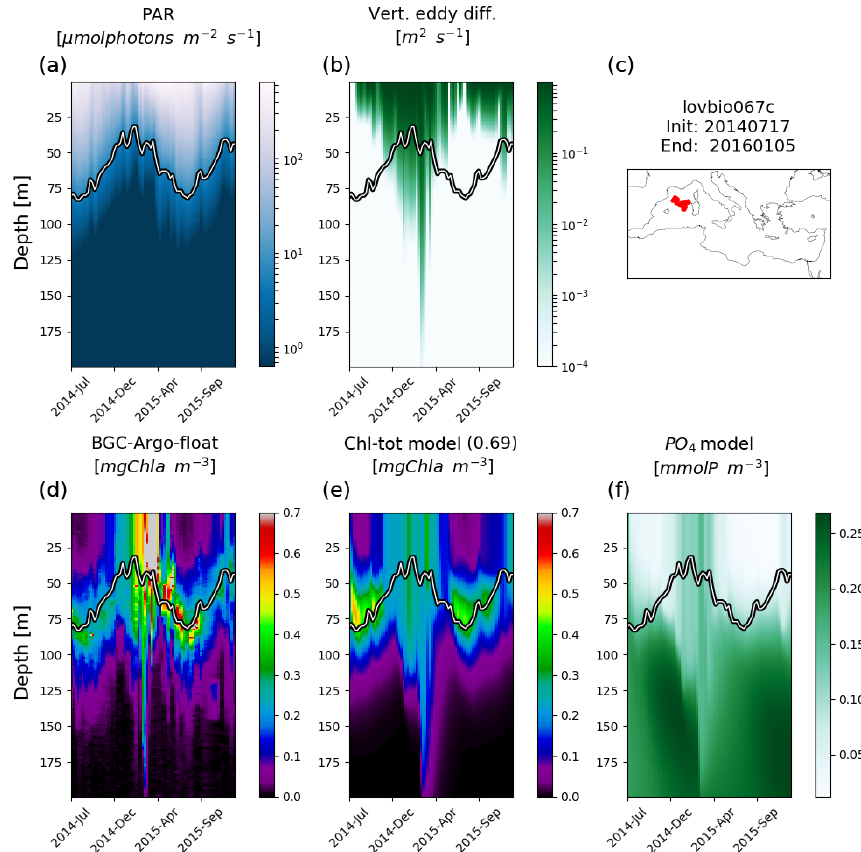
Figure 3. Hovmöller diagrams of BGC-Argo float lovbio067c (WMO code 6901649) comparing measured results and simulated ones (REF). The six-image composite is organized as follows: panels (a) , (b) , and (c) show PAR, vertical eddy diffusivity, and the float trajectory; panels (d) , (e) , and (f) show Chl derived from fluorescence measurements, simulated Chl, and phosphate. The thick black–white line indicates the depth where PAR equals 5.8µmolphotonsm − 2 s − 1 (Mignot et al., 2014). The number in parentheses in modelled Chl indicates point-by- point correlation with BGC-Argo float